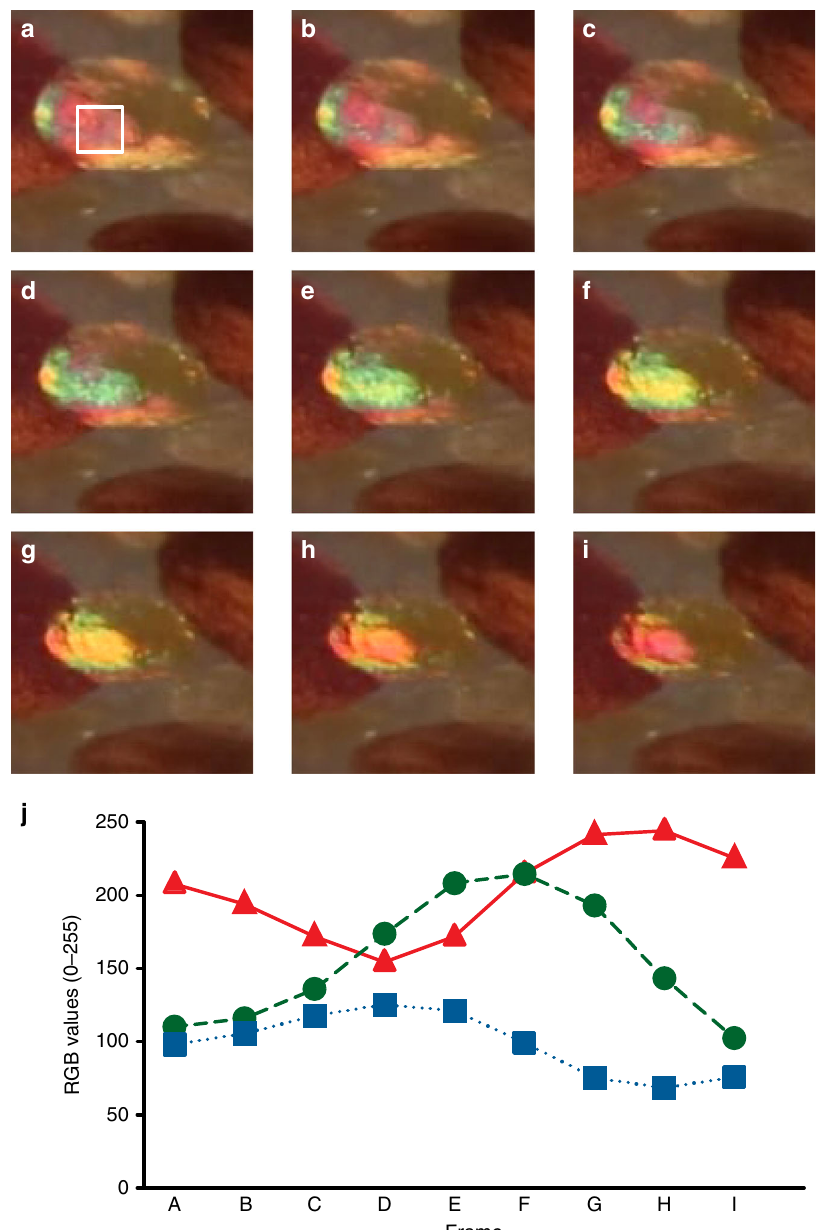
Fig. 3 Dynamic visible color emanating from a single chromatophore over time Consecutive Movie frames ( a – i ) taken from Supplementary Movie 2 (7.60 – 7.87 s, where each frame represents 0.03 s) showing the relaxation of a yellow chromatophore in the lower right-hand side. The white outline in a (20 × 20 pixel square) shows the location of the selected area used to measure RGB pro fi les in each frame. These frames were selected because they encompass the visible spectrum, giving unique red, green, and blue (RGB) values during the actuation cycle. j Using ImageJ software, the RGB values over the selected area were measured, averaged, and plotted from each frame, Here, the line graph shows the changes in RGB value intensities over time with the red triangles anchored by solid red lines representing red values, the green circles anchored by dashed green lines representing green values, and the blue squares anchored by dotted blue lines representing blue values. The changing RGB values shown here comprise a much wider range of colors than previously attributable to absorbance by any yellow chromatophores and constitute strong argument that dynamic structural color mechanisms must be